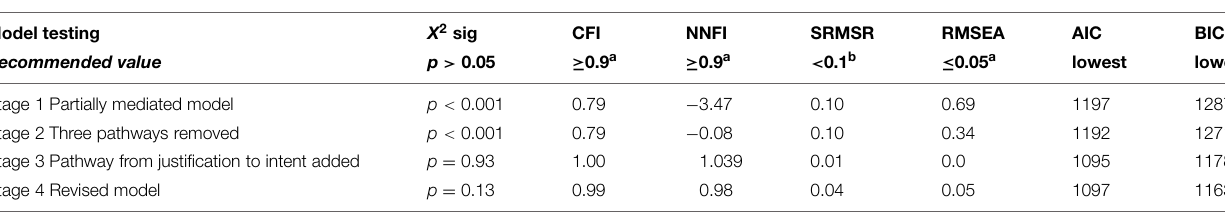
TABLE 4 | Fit indices for models tested.